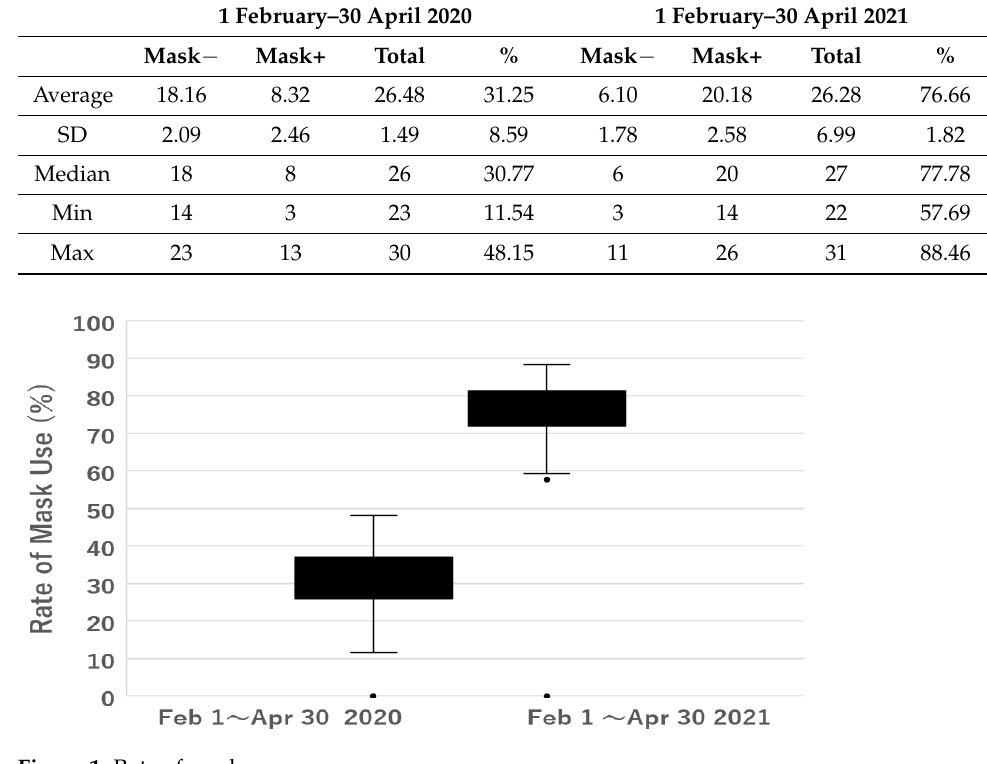
Table 1. Participant mask use in 2020 and 2021.